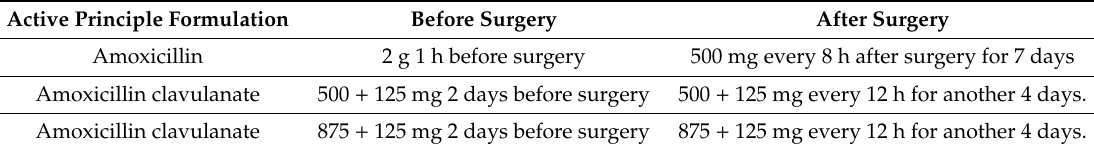
Table 4. Protocols involving amoxicillin